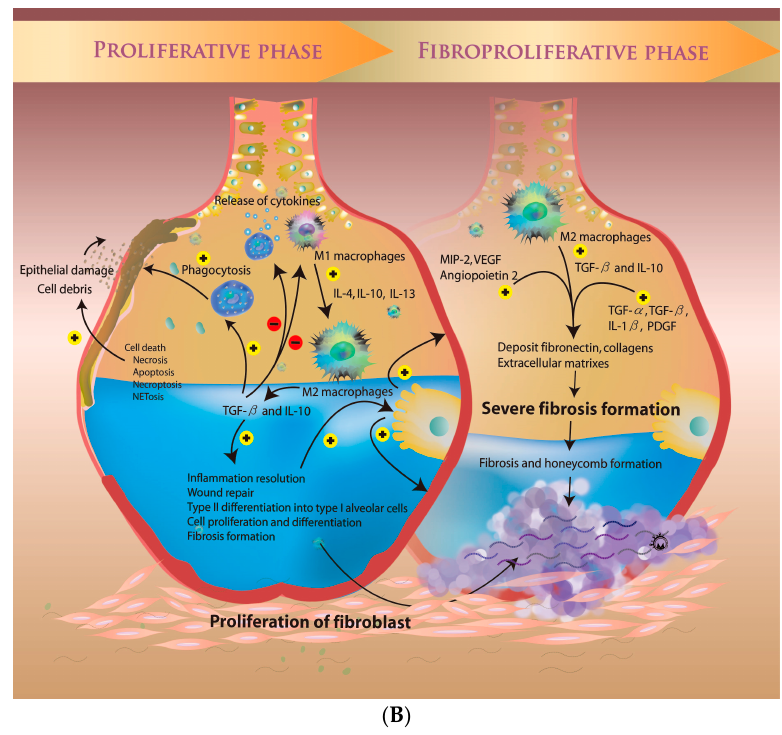
Figure 2. The molecular regulation of the pathogenesis of acute respiratory distress syndrome in four major phases: ( A ) Health and exudative phase ( B ) proliferative phase and fibroproliferative phase.